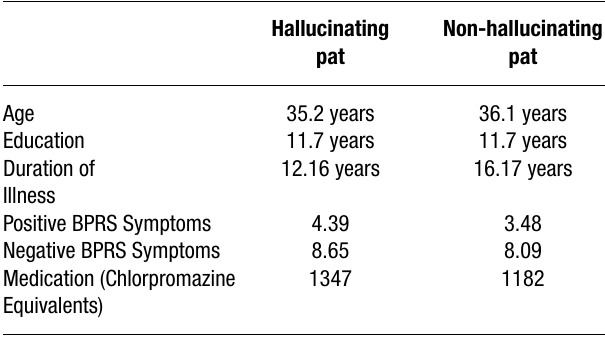
Table 1. Demographic data for the hallucinating and non-hallucinating